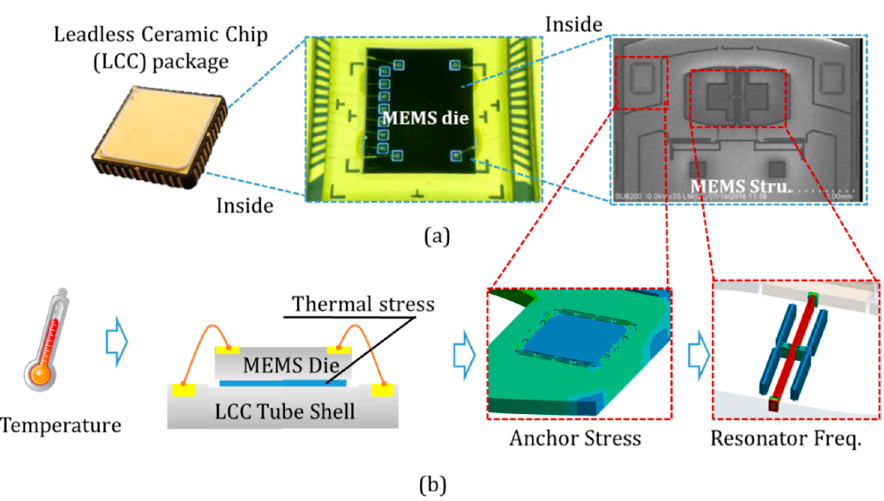
Figure 1. ( a ) Leadless Ceramic Chip (LCC) package with MEMS chip; ( b ) The mechanism of resonator frequency shift due to temperature.